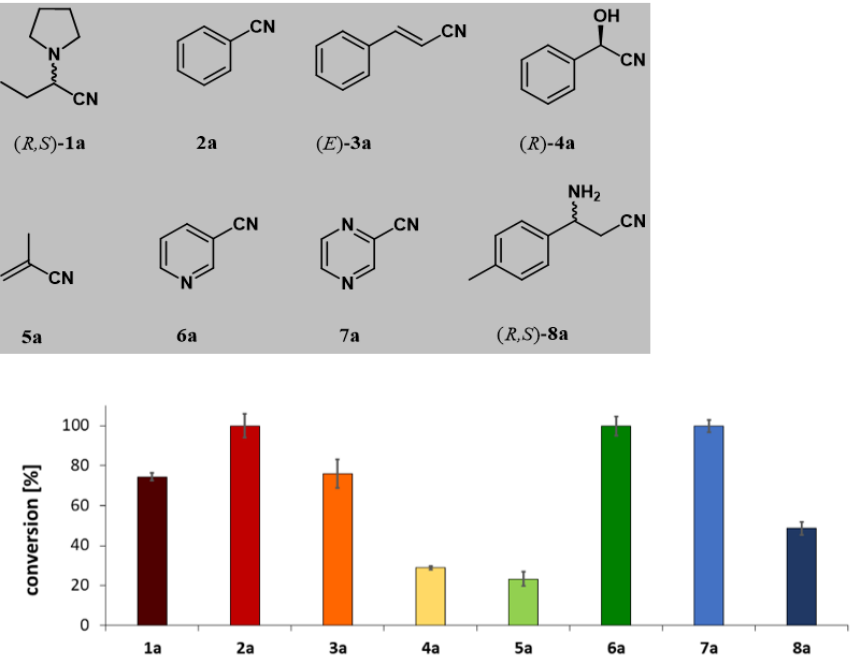
Figure 3. Substrate scope of Gh NHase. Top: chemical structures of investigated substrates. Bottom: nitriles a (50 mM) were converted by Gh NHase CFE (344 µg/mL NHase) at 25 °C and 500 rpm for 30 min. Each reaction was carried out in triplicate.